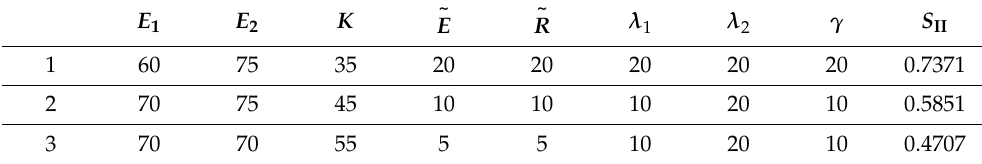
Table 4. Parameters setting and the values of S II in three situations (Unit: 10,000 Yuan). ~ ~ E 1 E 2 K E R